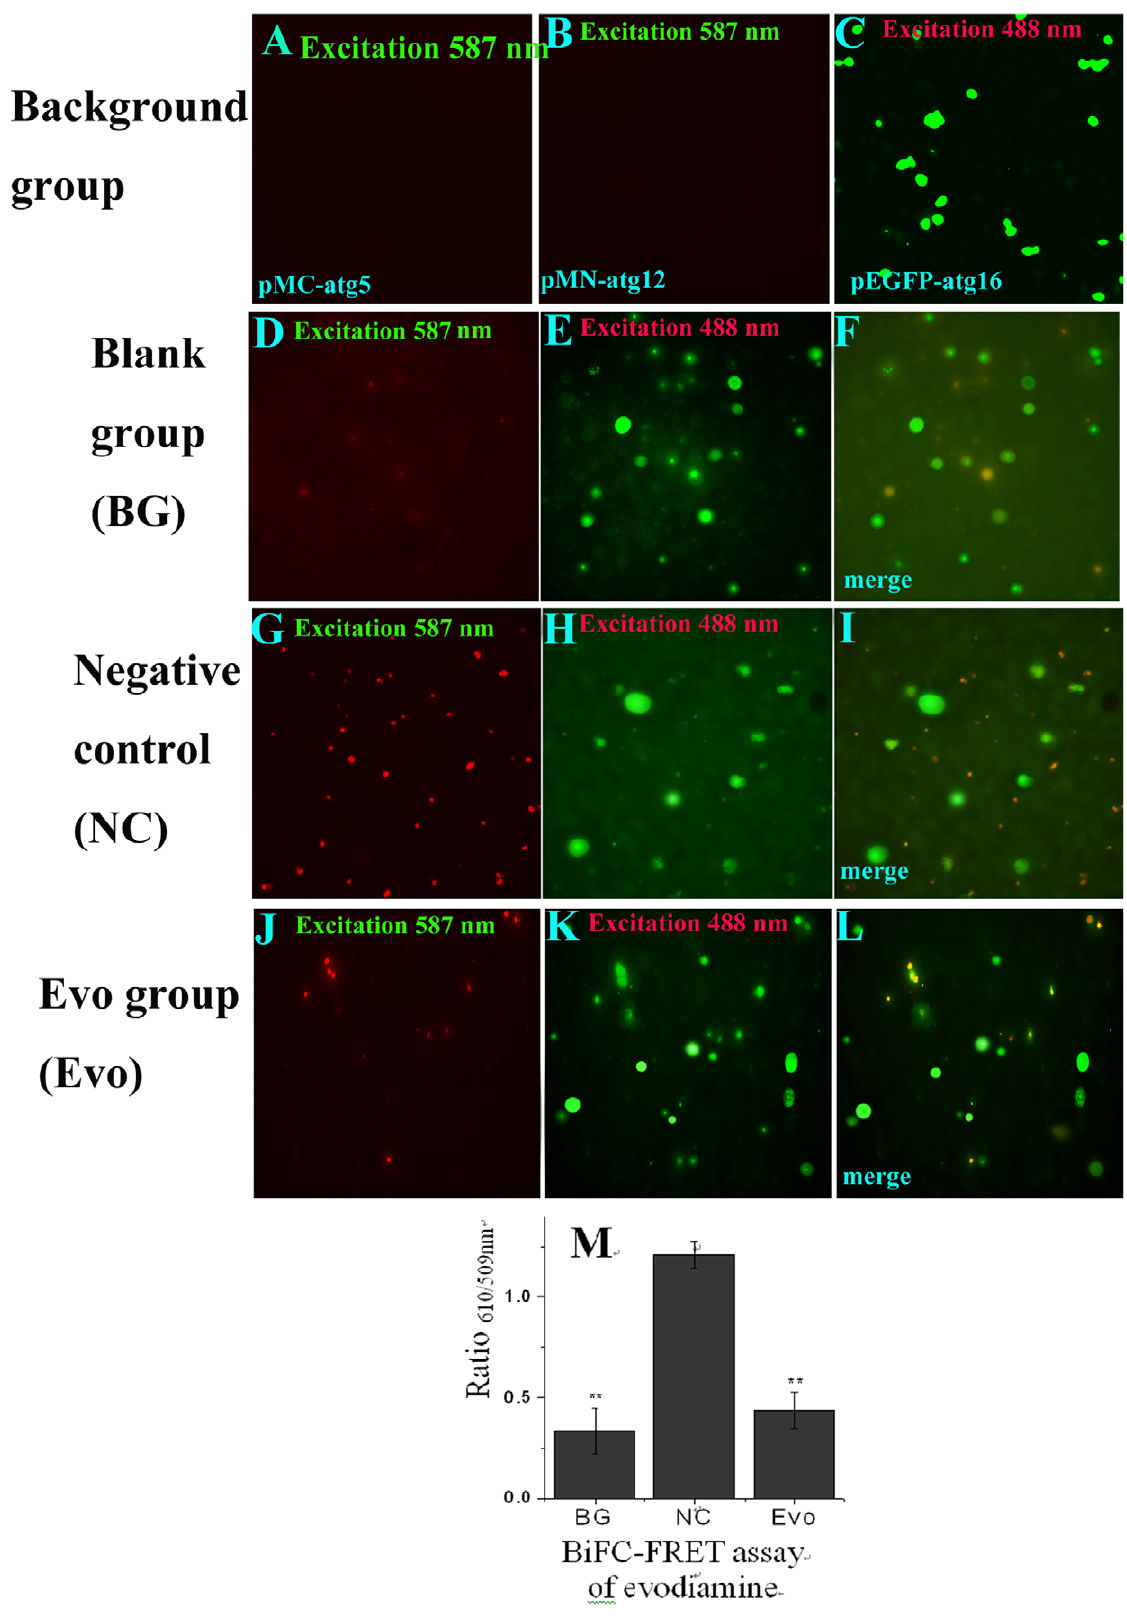
Figure 1. Evodiamine inhibits the interaction of Atg5, Atg12 and Atg16 determined by the BiFC-FRET assay. ( A , B ) The A549 cells were transfected with pMC-atg5 or pMN-atg12, respectively. ( C ) The A549 cells were transfected with the pEGFP-atg16 plasmid and treated with